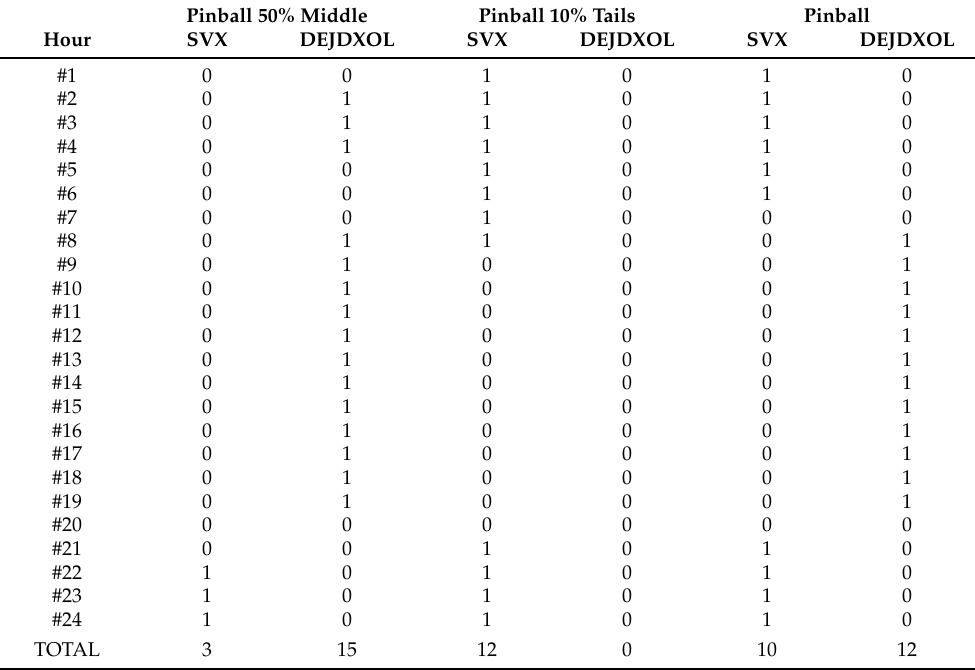
Table 2. The results of the Diebold-Mariano tests with the pinball scoring rule at a significance level of 0.05 separately for each hour of the day in the out-of-sample period (2 January 2017–26 March